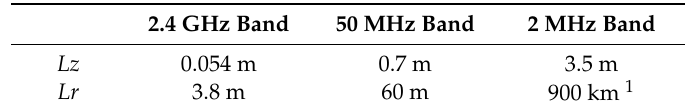
Figure 10. S 11 and S 22 of the antennas used in the experiments depicted in Figure 9. These parameters were measured in the lab in a seawater tank. A de-ionized water antenna enclosure was implemented during these measurements. Table 1. Summary of the theoretically predicted propagation range Lr and communication depth Lz (@ 5W transmit power) at the RF bands explored in this